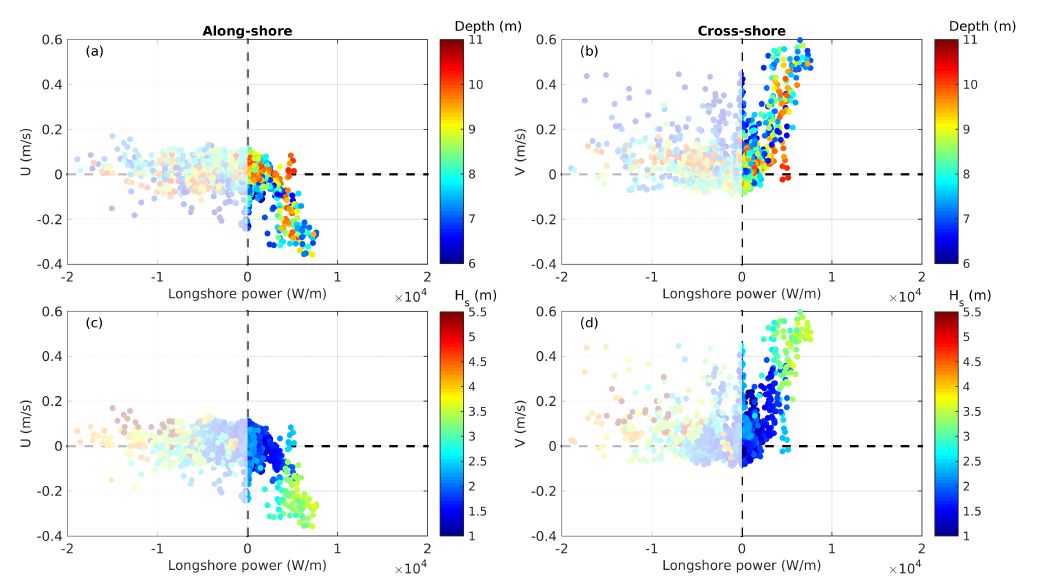
Figure 4. Scatter plot of depth-averaged and 2-h-averaged alongshore ( a , c ) and cross-shore ( b , d ) flow components against longshore power P l . Positive/negative longshore power corresponds to northern/southern waves, positive/negative alongshore velocity component U corresponds to northward/southward current and positive/negative velocity component V corresponds to off/onshore flow. In the top and bottom panels the water depth and significant wave height are colored, respectively. The present analysis focuses on the deflection regime for P l > 0 (right parts of the